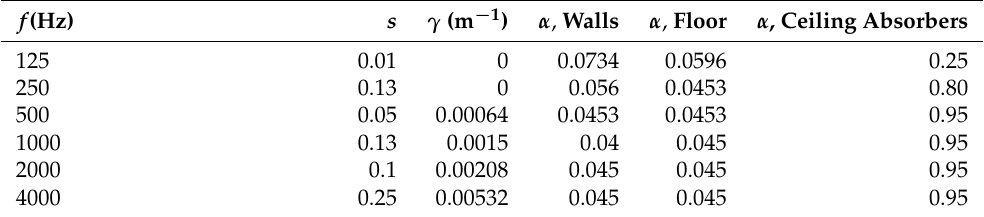
Table 1. Simulation parameters described for each octave band by frequency ( f ). s is the dimen- sionless surface scattering parameter, constant for all surfaces in the space. γ is the air attenuation parameter, defined in m − 1 . Finally, the dimensionless absorption coefficients α are given for the surfaces in the model. Note that the surface absorption parameters were not used in the simulations designed to evaluate the estimates of expected value and variance. Surface scattering and absorption parameters are based on calibration from earlier research